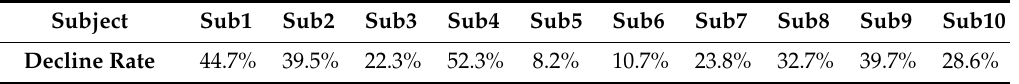
Table 10. Decline rate of mental fatigue.